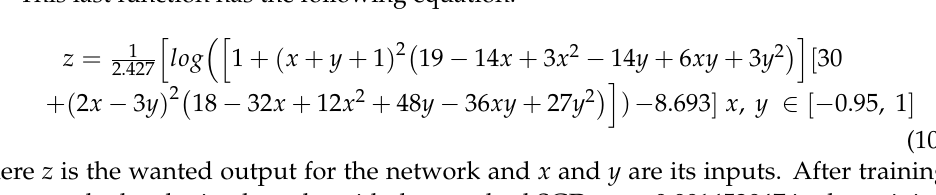
Figure 29. Unified best learned patterns cos(φ) on the ( left ) and | 𝜕𝐿𝑜𝑠𝑠 | on the ( right ) for the drop-wave function using the modified SGD with dynamic alpha and drop-out.